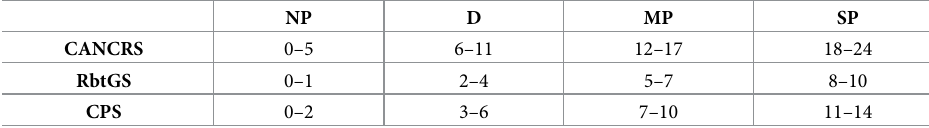
they were supported by the presence of images explaining how to evaluate the FAU considered by the RbtGS. Rabbits were scored during the first clinical examination and raters were instructed to first fill in the RbtGS part, assessing the rabbit visually from a distance, prior to opening the same carrier in which the rabbit was admitted to the hospital, in order to avoid further stress. Afterwards, raters had to interact with the patient and fill in the second part (CPS) of the scale, which included physiologic and behavioral data. Each patient was assigned a score for the RbtGS, the CPS and, consequently, for the com- posite pain scale. Score ranges were adjusted when evaluating Lop eared rabbit, since ear posi- tion was not assessable. Pain scores ranged from 0 to 24 for the CANCRS or from 0 to 22 for the Lop eared rabbit version of the CANCRS, from 0 to 14 for the CPS and from 0 to 10 for the RbtGS or from 0 to 8 for the Lop eared rabbit version of the RbtGS. In order to make the com- parison between scales possible, for each scale, the scores were divided into four classes: no pain (NP), discomfort (D), moderate pain (MP), severe pain (SP); this allowed comparison with the four classes belonging to the PP (presumptive pain). Score ranges for the aforemen- tioned classes are shown in Table 3. Table 3. Ranges of the scores for each class of pain in CANCRS, RbtGS and CPS. NP D MP SP CANCRS 0–5 6–11 12–17 18–24 RbtGS 0–1 2–4 5–7 8–10 CPS 0–2 3–6 7–10 11–14 Scores were equally distributed in four pain classes. For CANCRS, scores from 0 to 5 were classified as NP, scores from 6 to 11 were classified as D, scores from 12 to 17 were classified as MP and scores from 18 to 24 were classified as SP. For RbtGS, scores from 0 to 1 were classified as NP, scores from 2 to 4 were classified as D, scores from 5 to 7 were classified as MP and scores from 8 to 10 were classified as SP. For CPS, scores from 0 to 2 were classified as NP, scores from 3 to 6 were classified as D, scores from 7 to 10 were classified as MP and scores from 11 to 14 were classified as